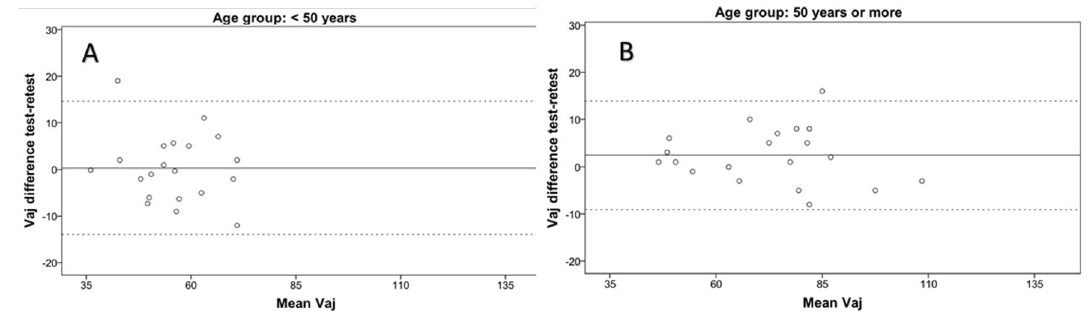
Figure 1. Test–retest Bland–Altman analysis of the vertical sheets in subjects with less than 50 years ( A ) and subjects with 50 years old or more ( B ). Data of both axes are presented in seconds. The continuous horizontal line represents the mean difference and the two non-continuous lines the limits of agreement. Vaj vertical adjusted time.